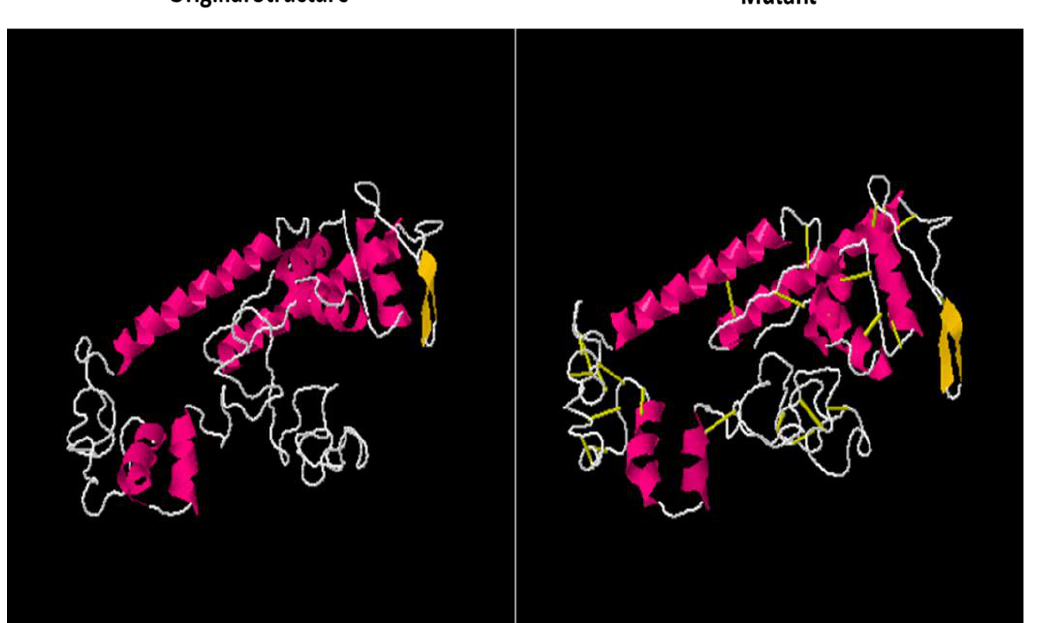
Figure 7. Original and mutant structure of the MEV construct. The yellowish highlighted areas in the mutant shows the introduction of the disulfide bonds into the structure. Table 7. The pairs of amino acid residues. Chi3 values and energy .